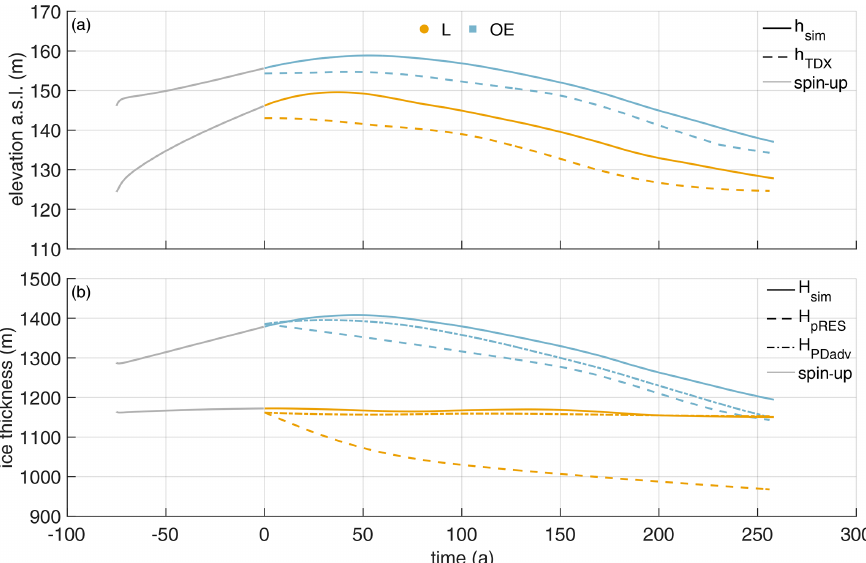
Figure 6. First experiment: simulated surface elevation (a) and ice thickness (b) using the pRES-derived melt rate. Colors denote quantities above the channel (yellow) and outside the channel (blue). (a) Simulated surface elevation h sim (solid lines) and observed h TDX (dashed lines). (b) Simulated ice thickness H sim (solid lines), under present-day climate conditions advected H PDadv (dashed-dotted lines) and observed H pRES (dashed lines). Gray lines represent the spin-up.